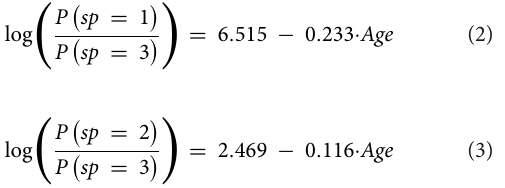
The dummy variables are created based on the categorical variables that have an association with the dependent variable Academic Results ( res _ acad i where i is the